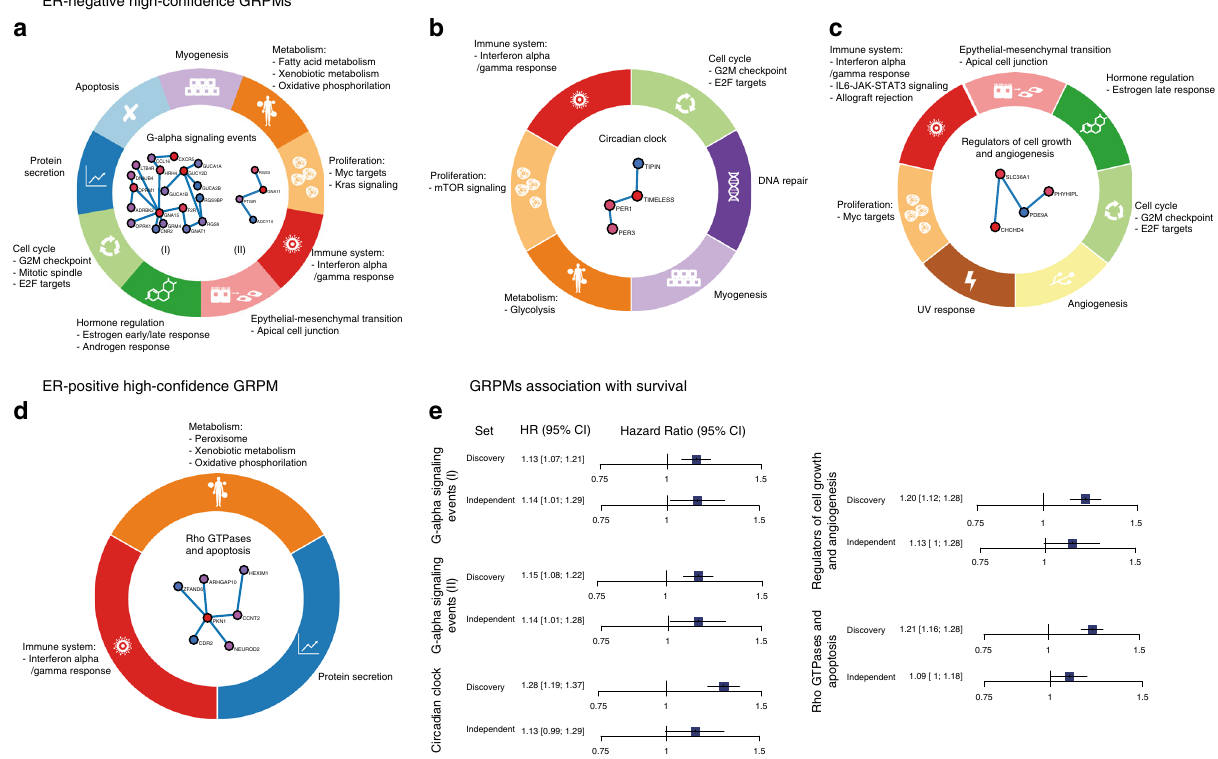
Fig. 3 High-con fi dence germline-related prognostic modules (GRPMs). The GRPM is shown at the center of the circles, surrounded by the biological processes enriched among the downstream transcriptional effects of each module. Three modules were found for estrogen receptor (ER)-negative breast cancer ( a – c ) and one module was found for ER-positive breast cancer ( d ). a G-alpha signaling GRPMs. b Circadian clock GRPM. c Regulators of cell growth and angiogenesis GRPM. d Rho GTPases and apoptosis GRPM. e Plots illustrating the association between each GRPM ’ s PHS and 10-year breast cancer speci fi c-survival in the discovery and independent sets. HR hazard ratio (per standard deviation of the PHS), CI con fi dence interval. The error bars show the 95% con fi dence interval. The con fi dence intervals shown are two sided, whereas the signi fi cance test performed was one sided (see “ Methods ”